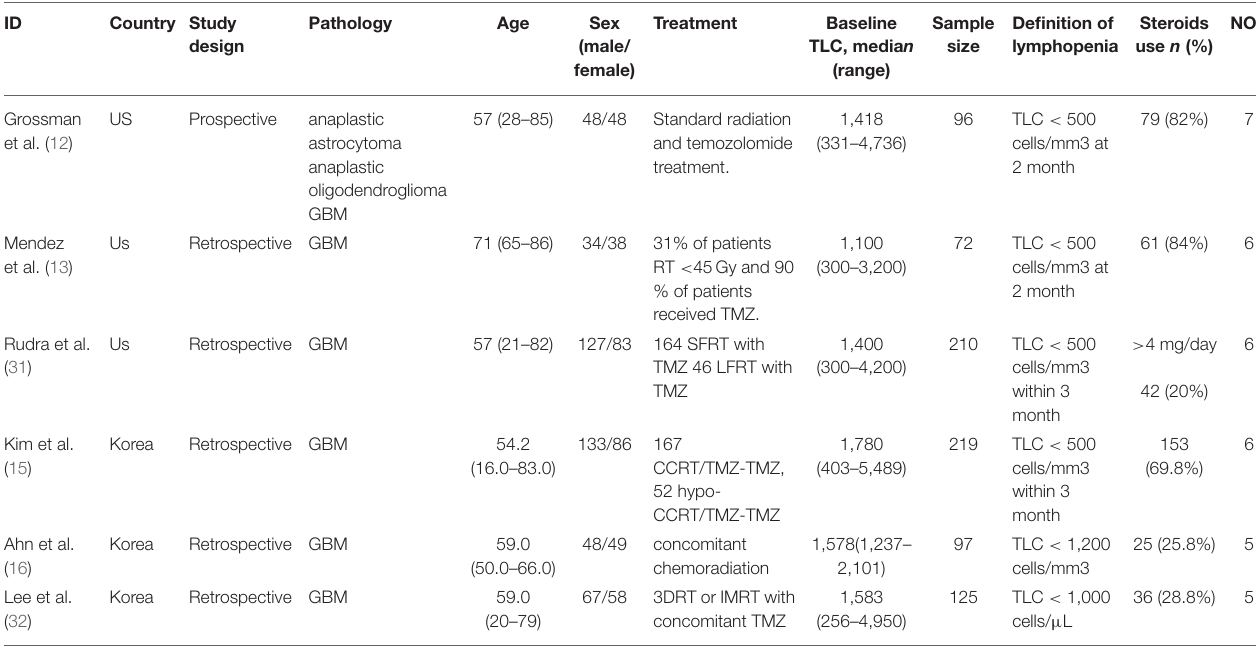
TABLE 2 | The main characteristics of studies included in this meta-analysis for